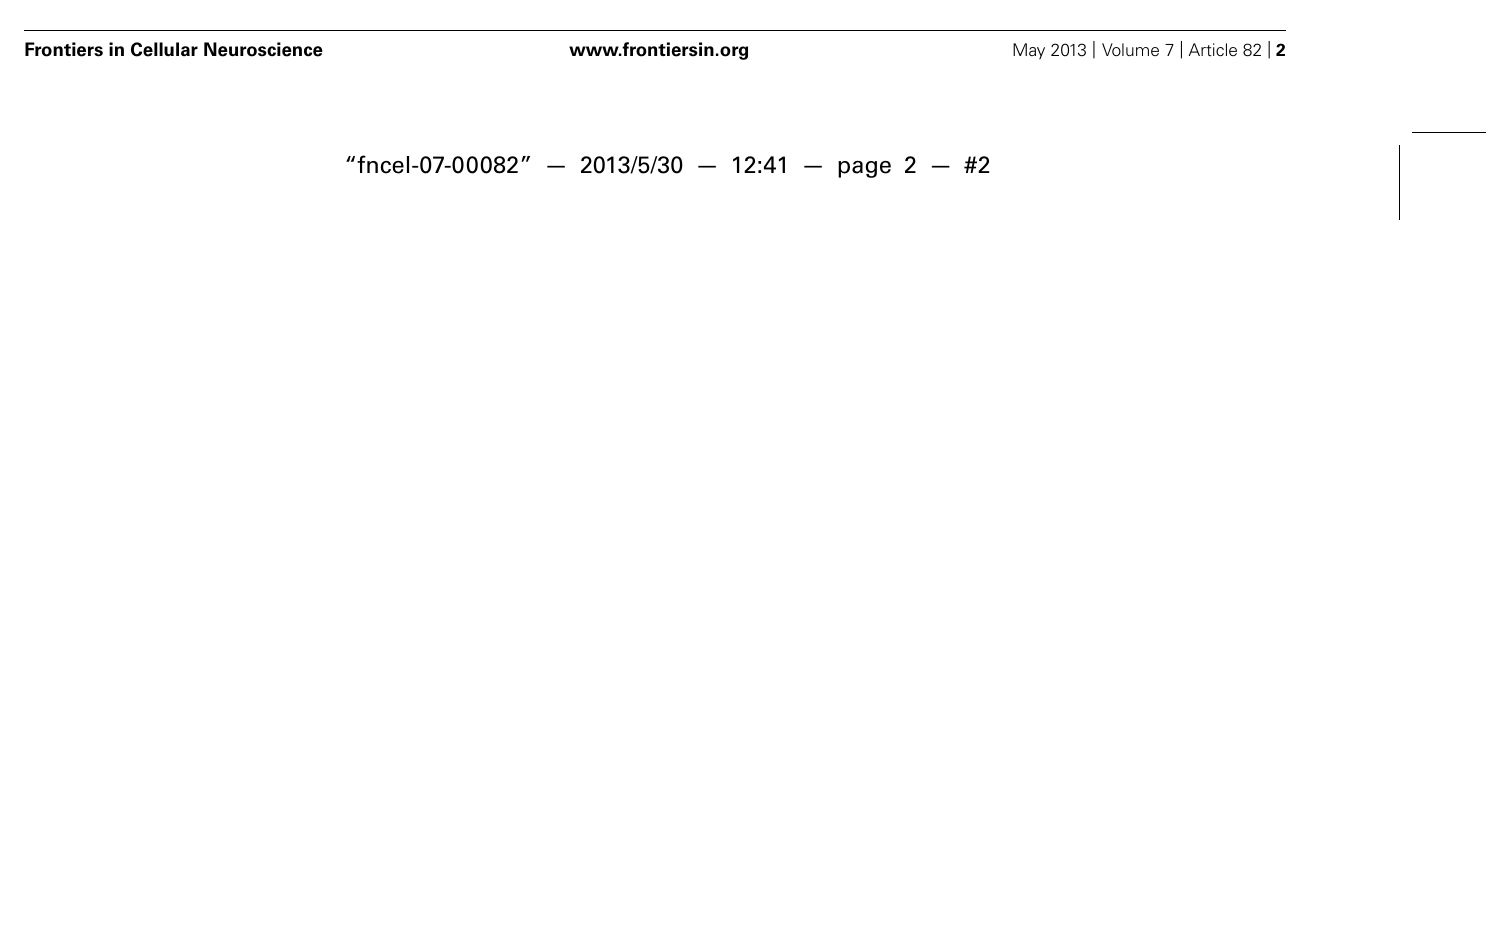
FIGURE 1 | Domain structure of LRRK2. Domains are color-coded according to function: those implicated in protein–protein interaction are depicted in blue; domains involved in GTPase function are green; and the kinase domain red. Here, LRRK2 is depicted as a dimer, although LRRK2 also exists as monomers and in higher molecular weight complexes (Greggio etal., 2008). Dimerization is likely to be mediated by the COR and/orWD40 domains (double-headed arrows). COR domains are established as dimerization devices in ROCO proteins (Gotthardt etal., 2008), whilst ablation of theWD40